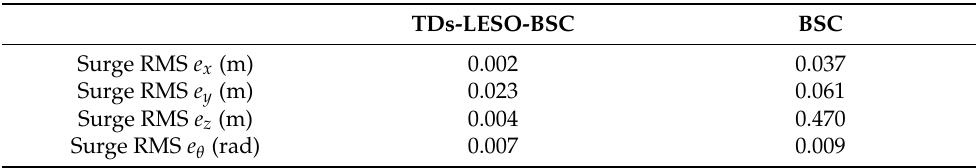
Figure 16. The contrasts of the state tracking errors in the spiral trajectory tracking case. Table 3. The RMS errors of the TASR in the spiral trajectory